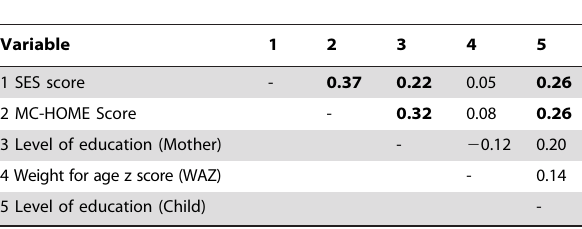
Table 2. Correlations between socioeconomic variables.